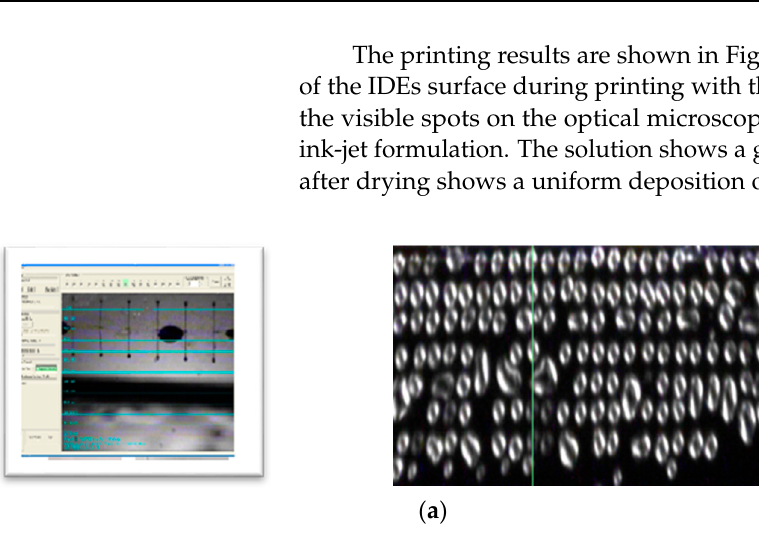
Figure 15. ( a ) Images during the printing process of the PANI:PSS/SWCNT ink with Dimatix DMP 2800; ( b ) Optical microscope image if PANI:PSS/SWCNT on one pair of IDE.